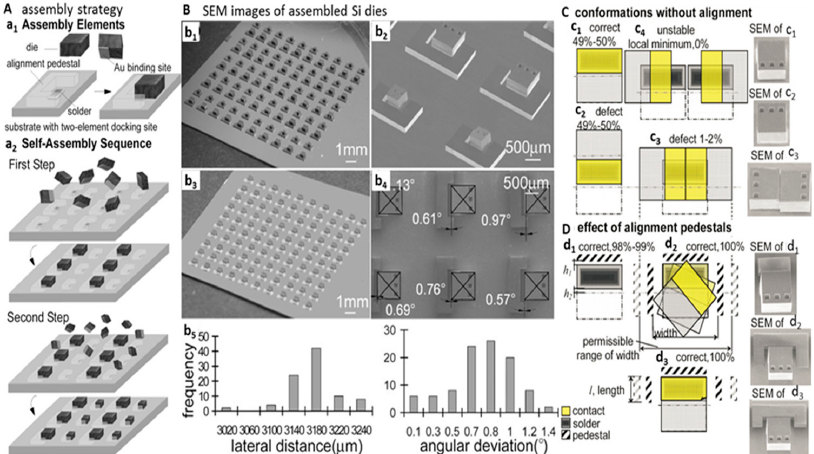
Figure 3. Strategy ( A ) results ( B ) and design rules ( C ) to assemble and connect chip-scale components with different dimensions, single-angular orientation, and contact-pad registration. ( a 1 ) Self-assembly elements depicting dies with a gold contact and two-element docking sites containing alignment pedestals and solder-coated areas. ( a 2 ) Two-step self-assembly sequence to populate the substrate with different components. The reduction of the interfacial free energy drives the assembly process into a stable position. ( b 1 – b 4 ) SEM images of silicon dies that have been assembled using a combination of alignment pedestals, solder-coated areas, and sequential batch transfer. 10 ˆ 10 array that contains alternating rows of 900 µ m and 500 µ m dies that are surrounded by Si alignment pedestals ( b 1 , b 2 ) and SU-8 alignment pedestals ( b 3 , b 4 ) that was used to study the alignment accuracy. ( b 5 ) Histograms of the measured values. ( C ) Computer-aided design (CAD) approach that is used to eliminate defects and establish design rules together with experimental results. Rectangular receptor/binding site design that favors the 0 ˝ ( c 1 ) and 180 ˝ ( c 2 ) angular orientation along with predictions of defects ( c 3 ) and ( c 4 ). ( D ) Alignment-pedestal designs to eliminate defects. ( d 1 ) Single-pedestal designs with h1 ď h2 eliminate the 180 ˝ conformational overlap and yield the correct orientation in 98% of the cases. ( d 2 , d 3 ) Pedestals on the side eliminate the attachment of two components. l and w indicate the permissible range of the opening to ensure defect-free assembly. Reprinted with permission from